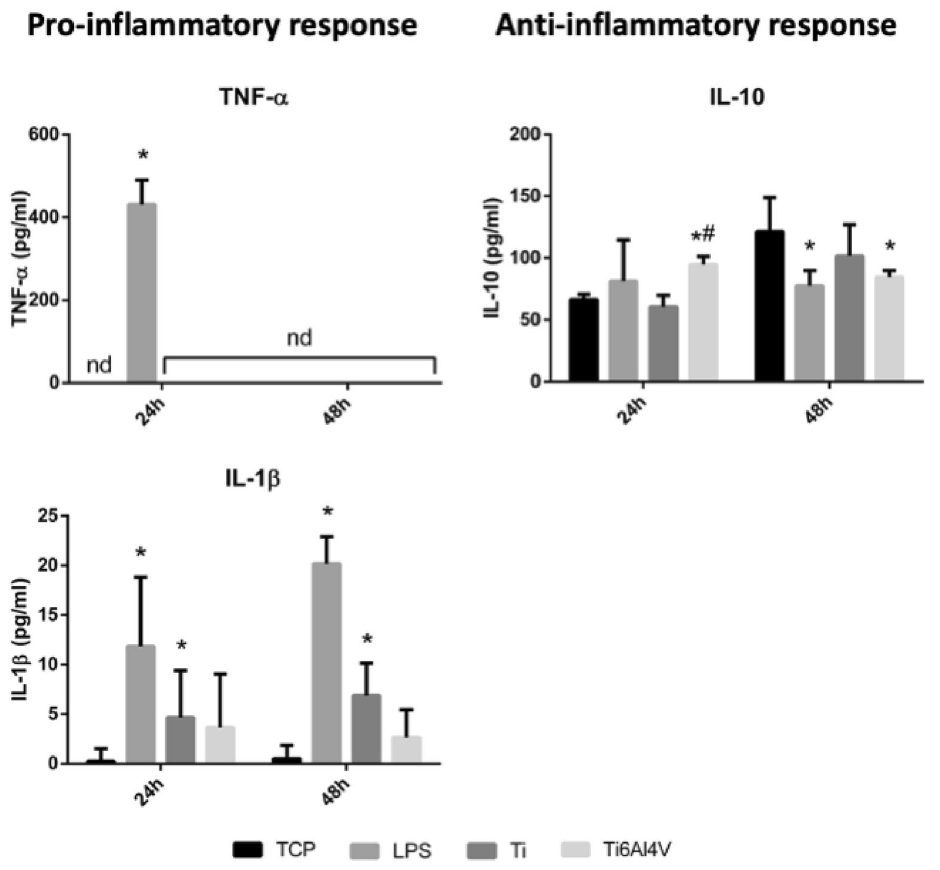
Figure 3. Effect of stimulation with Ti and Ti6Al4V alloy extracts upon the release of proinflammatory (TNF-α and IL-1β) and anti-inflammatory cytokines (IL-10) in the THP-1 macrophage cell line. Statistically significant differences ( p < 0.05) are represented with * when comparison was made versus TCP and with the symbol # when comparison was made versus Ti.